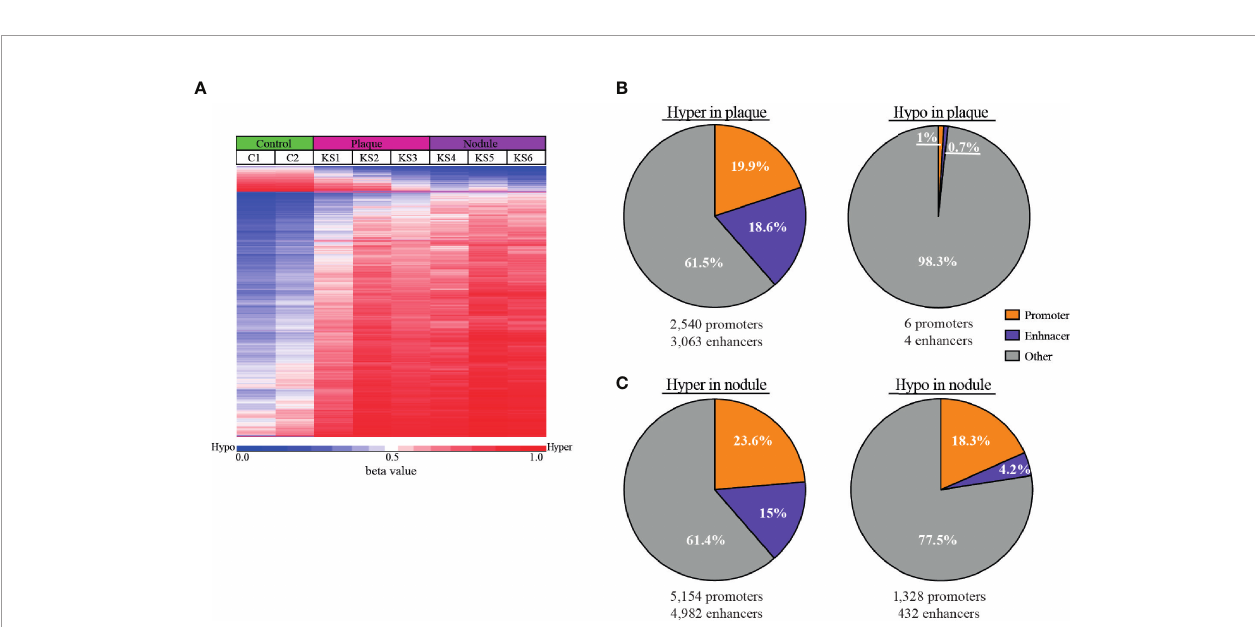
FIGURE 3 | Hyper-methylation in KS is prevalent in enhancer regions. (A) Heat map of the most differentially methylated CpG sites (raw b values) comparing control and KS samples. Hyper (red) and hypo (blue) methylation threshold was set as Db ≥ 0.25 and Db ≤ -0.25 respectively with FDR ≤ 0.05. (B, C) Pie charts representing the percentage of hyper and hypo-methylated CpGs that are located within cellular promoters (orange) and enhancers (purple) for plaque (B) and nodule (C) . The number of cellular enhancers and promoters identi fi ed in our analysis are presented